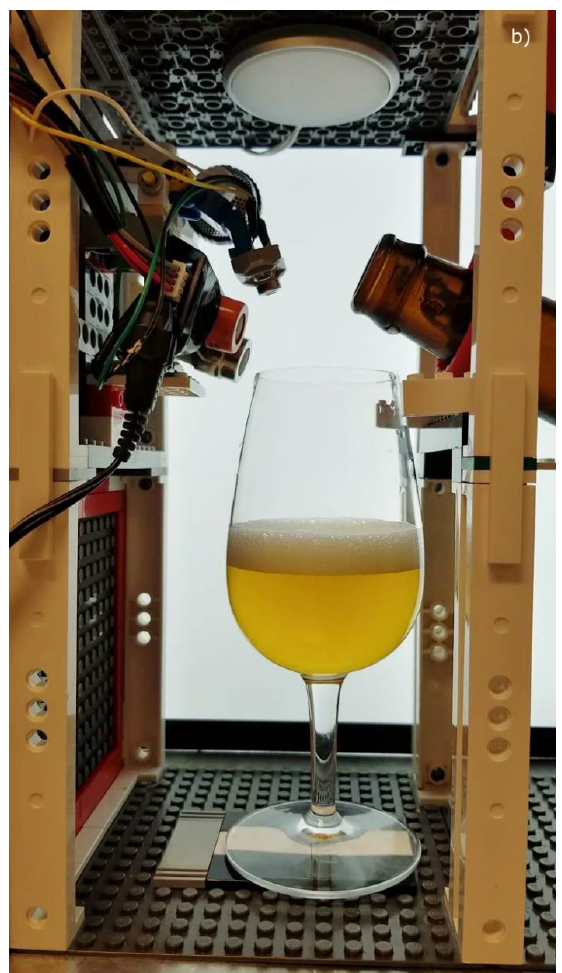
Figure 1. Equipment used to assess beers physical measurements; ( a ) robotic pourer, RoboBEER, which was used to assess the color and foam-related parameters and ( b ) a frame of a video taken to analyze the beer using computer vision algorithms.